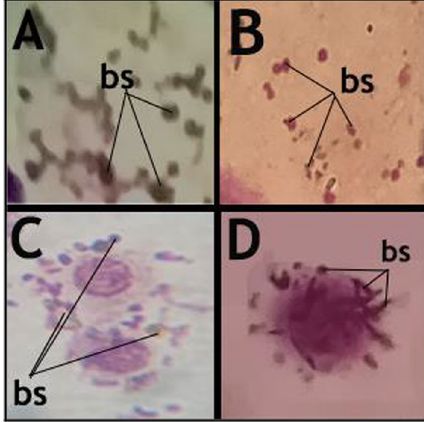
Fig. 12 Blastospores growth in haemocoel of examined Agrotis ipsilon larvae ( x 1000). bs: Metarhizium anisopliae =